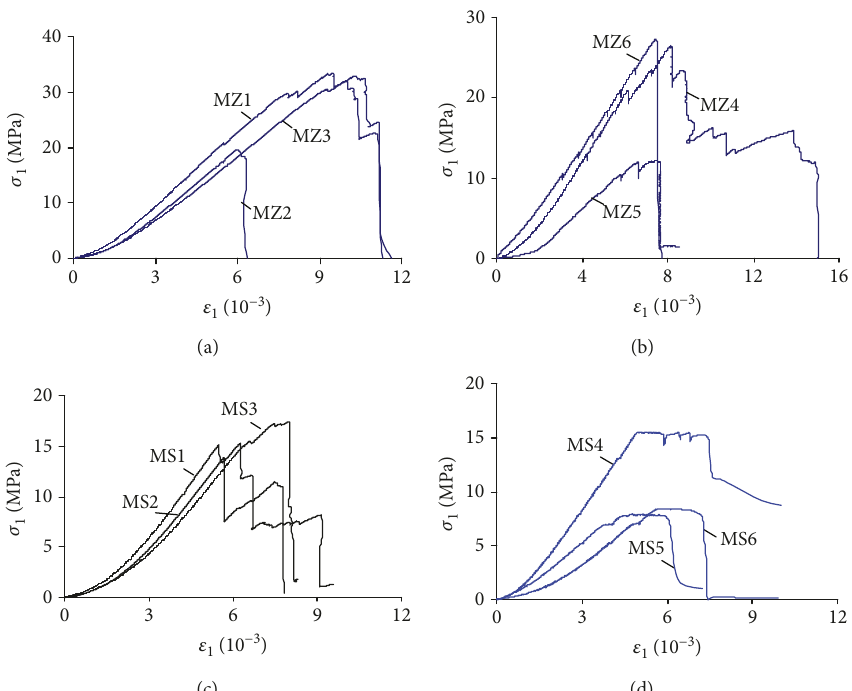
Figure 3: Stress-strain curves of the uniaxial compression and step loading